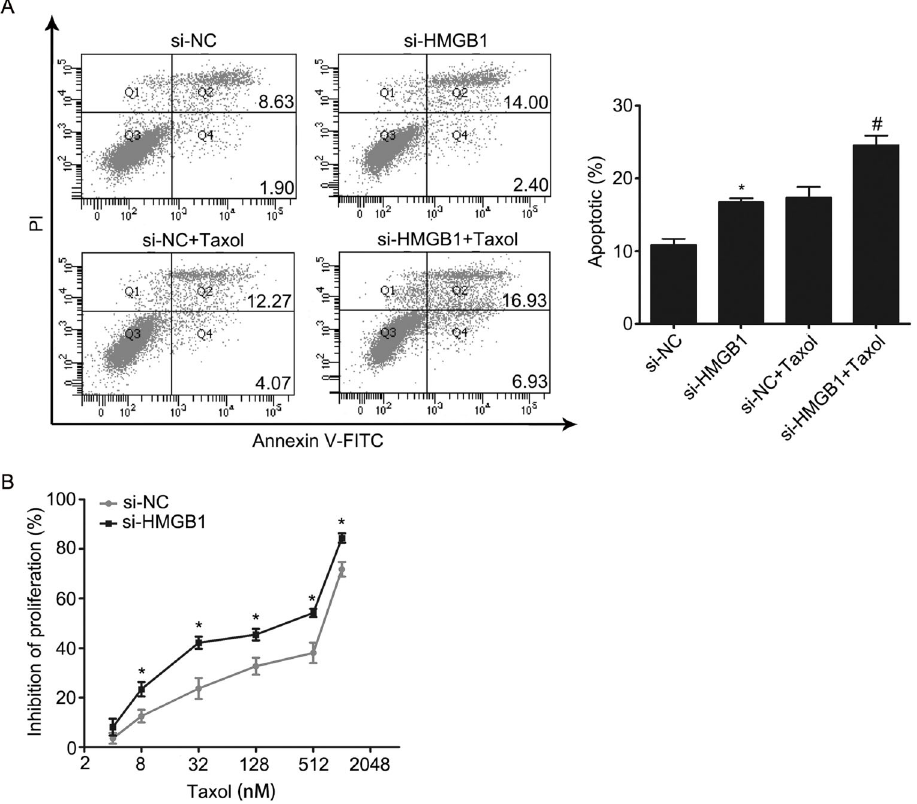
Figure 6. Interference of HMGB1 enhanced chemosensitivity of Taxol by promoting apoptosis in MCF-7 cells. A , Cellular apoptosis was determined by fl ow cytometry. The total rate of apoptotic cells is represented in a bar diagram from three independent experiments (right panel). B , Cells were transfected with si-NC or si-HMGB1, and then treated with different concentrations of Taxol for 24 h. Cell proliferation was determined by the CCK-8 assay. Data are reported as means ± SD of three independent experiments. *P o 0.05,